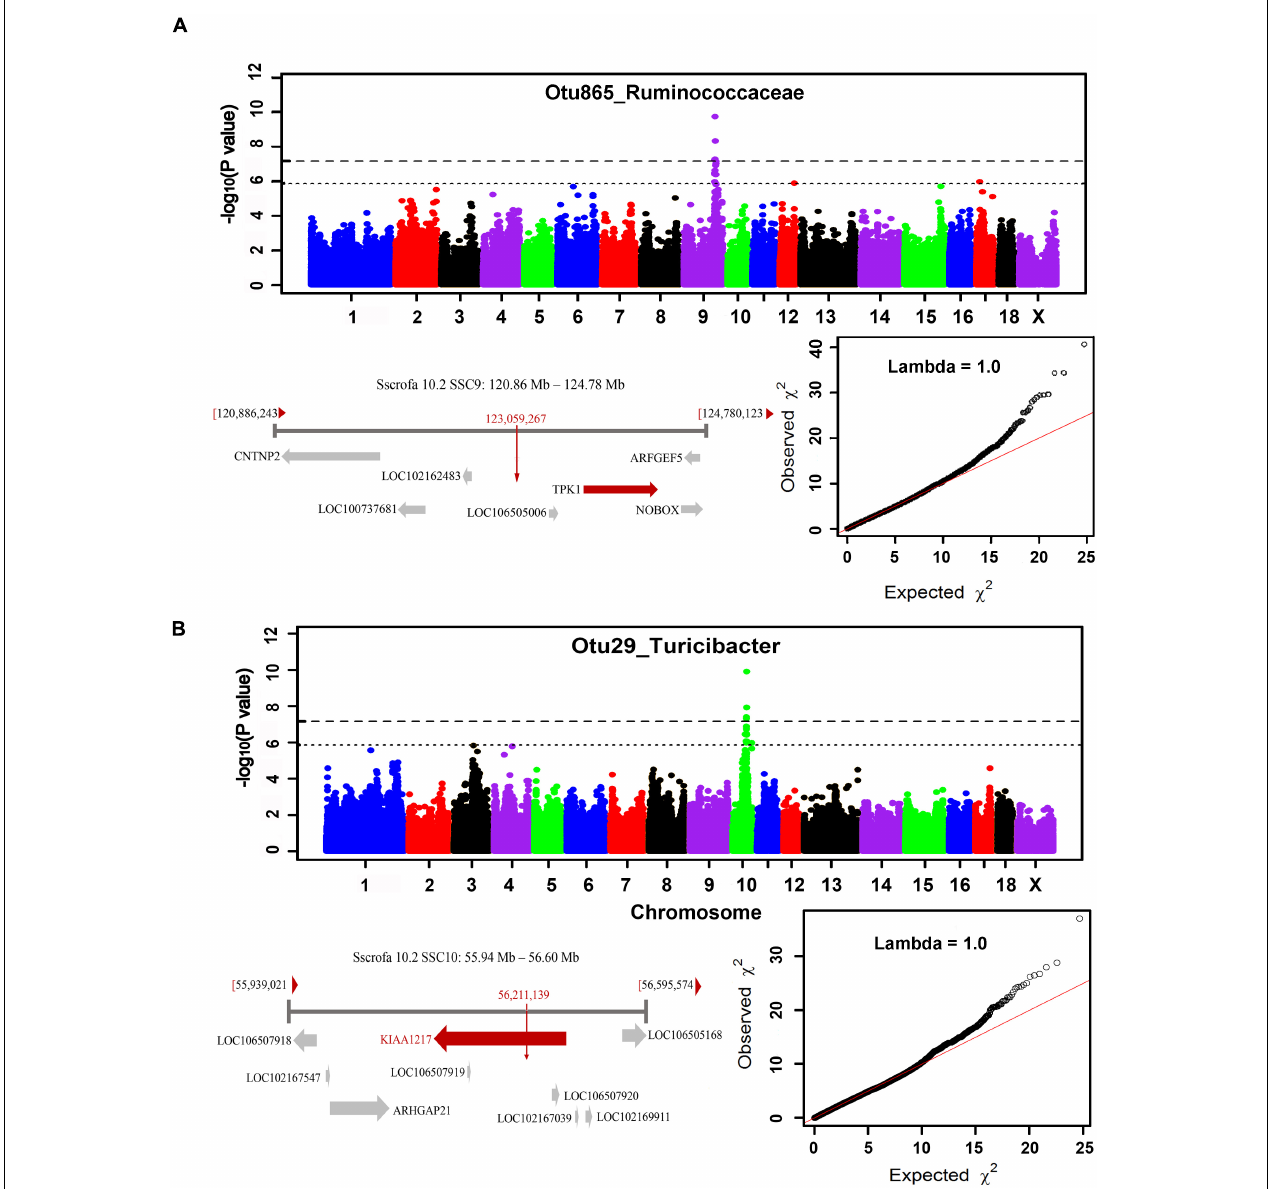
FIGURE 6 | GWAS results and candidate gene annotation for Ruminococcaceae (A) and Turicibacter (B). For Manhattan plots, X-axis shows chromosomal positions. Y-axis shows –log10 P -values from GWAS. The horizontal dotted lines indicate the thresholds of genome-wide and suggestive significance level. Candidate gene closest to the top SNP for each locus was identified based on Porcine reference genome assembly 10.2 in Ensemble. The red vertical lines indicate the positions of the top SNPs. The red horizontal arrow bar represents the closest